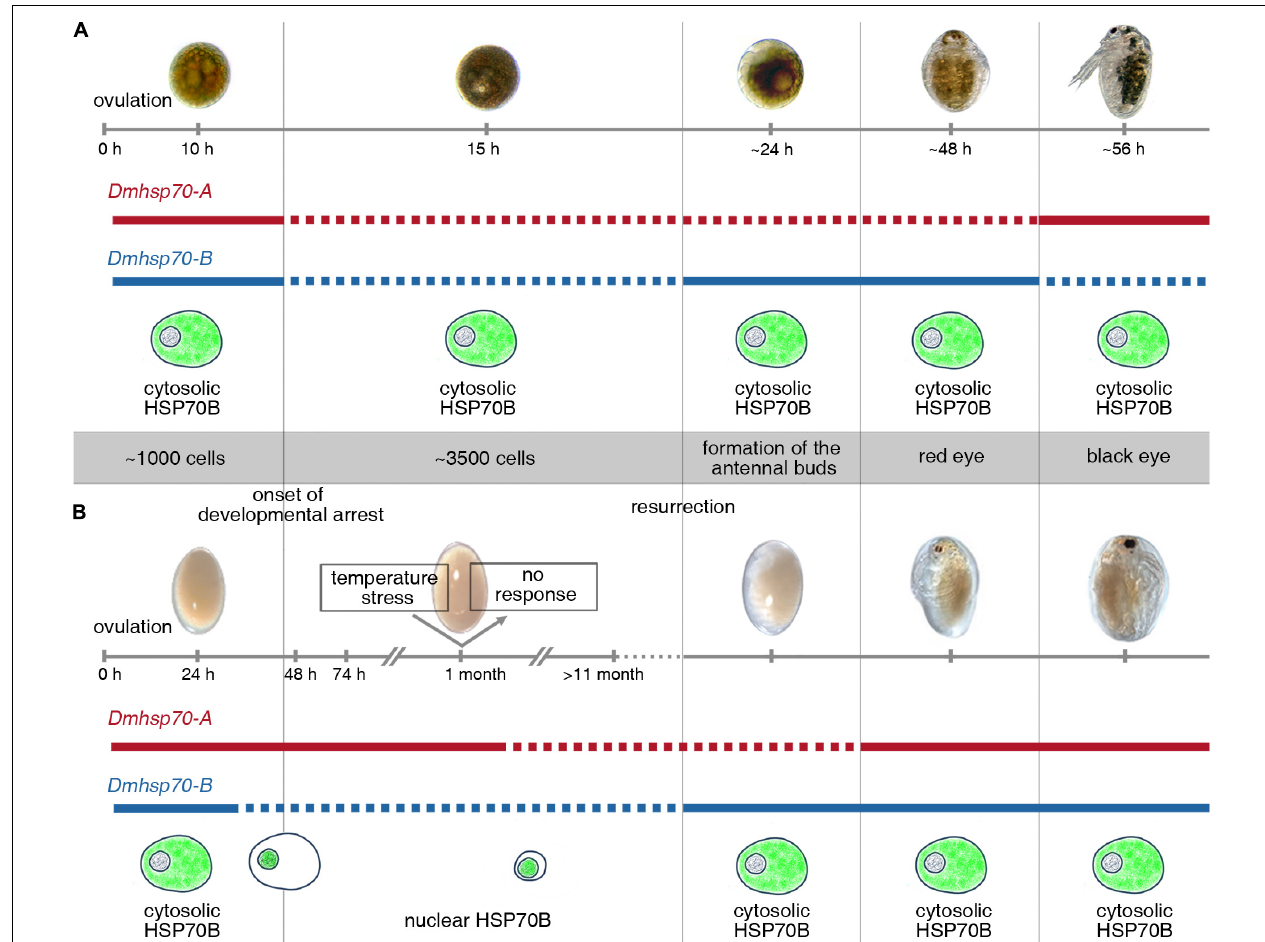
FIGURE 8 | Schematic display of expression patterns of Dmhsp70-A and Dmhsp70-B and cellular protein distribution of HSP70B (gene product of Dmhsp70-B ) involved in embryonic diapause of D. magna . (A) Gene expression analysis in continuously developing asexually produced embryos shows that Dmhsp70-A and Dmhsp70-B are initially high to become significantly reduced within first 15 h of development and is hypothesized to be a result of use of maternally provided mRNA. Once development progresses, Dmhsp70-A expression levels remain downregulated, and Dmhsp70-B is significantly upregulated, indicating Dmhsp70-B involvement in continuous development. Once embryo reaches late embryonic stage before release from brood pouch, expression patterns of both genes are inverted, indicating that Dmhsp70-A is involved in dedicated housekeeping functions. This is further supported by fact that Dmhsp70-A expression levels only mildly exceed housekeeping gene expression level. During continuous development, HSP70B is continuously located in cytosol of cells, where it may engage in normal housekeeping functions such as coordination of protein translocations. (B) Gene expression analysis in diapause interrupted sexually produced embryos shows that Dmhsp70-A is significantly upregulated during diapause preparation and remains high during first phases of diapause (i.e., at least up to 30-day post-ovulation). This indicated Dmhsp70-A might be involved in initiating diapause. This is further supported as older embryos 11 months and older expression level significantly declines with time. During this same time, Dmhsp70-B is continuously downregulated and stays at a low level. HSP70B is limited to nuclear area cells, where it may engage in cellular clearance mechanisms. Upon resurrection, Dmhsp70-B significantly increases in expression but not Dmhsp70-A , again pointing to an involvement of Dmhsp70-B in continuous development. Just before reaching juvenile stage, both genes are mildly expressed and point to their involvement in general housekeeping